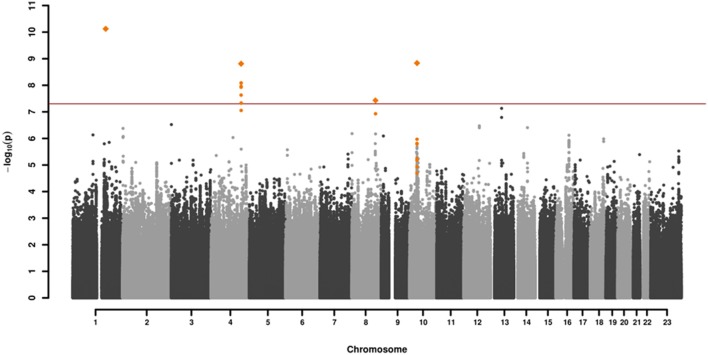
Manhattan plot of the genome-wide association analysis of 131 cases and 2,609 controls. The x-axis shows the chromosomal position, the y-axis the significance of association [–log10(p)]. The red line shows the genome-wide significance level (5 × 10−8). Genomic variations in orange are in LD (r2 > 0.6, p = 0.0001) with the index SNVs (diamonds) which represent independent genome-wide significant associations (r2 < 0.1).